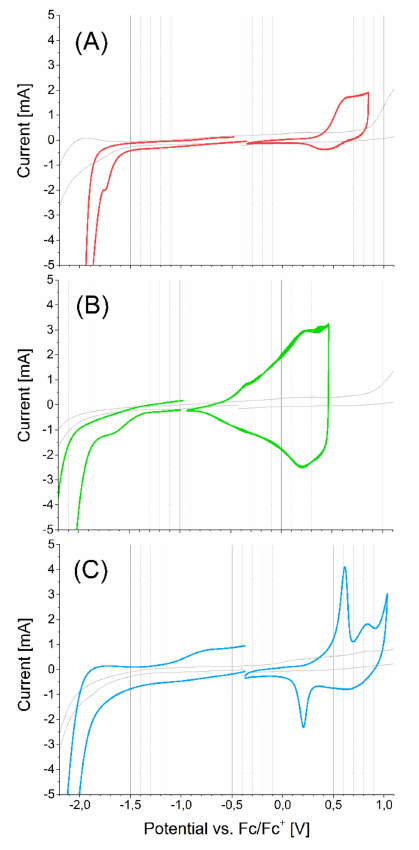
Figure 7. The CV of ( A )-P1, ( B )-P2, ( C )-P3 polymers films on Pt wire versus ferrocene redox couple in DCM, 100 mV /